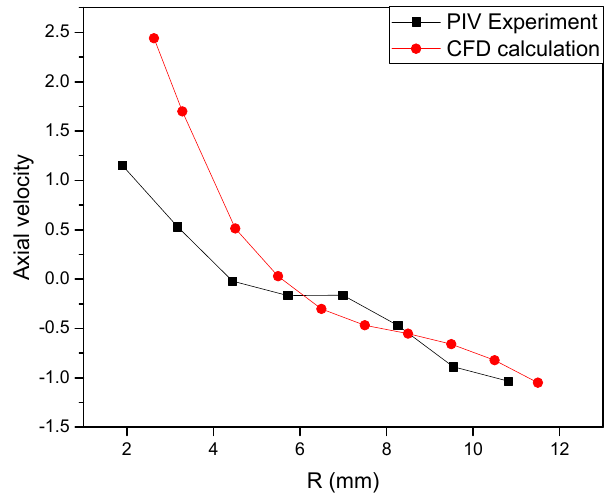
Figure 3. Axial velocity compared between experiment and calculation.